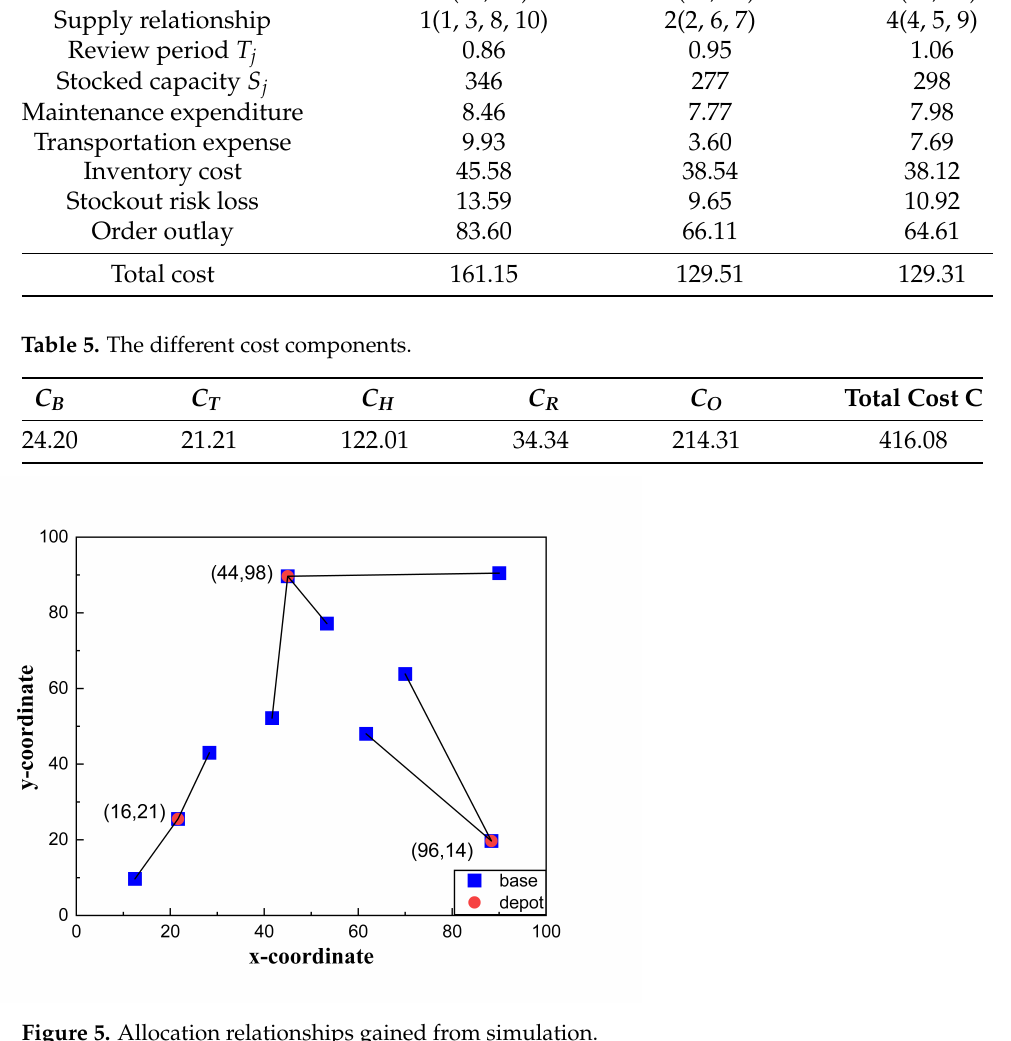
Figure 5. Allocation relationships gained from